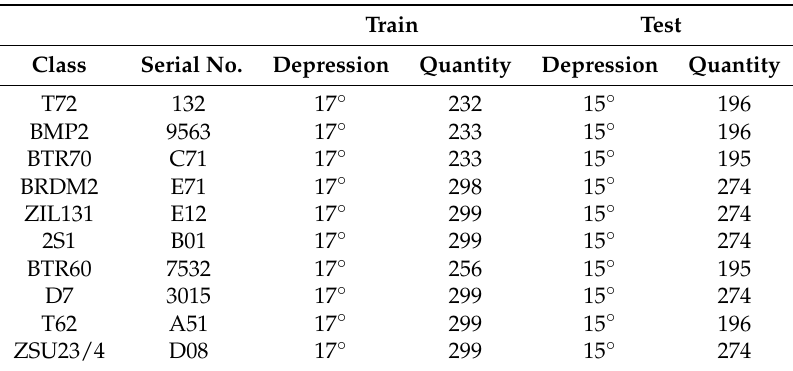
Figure 7. Experiment samples of 10 targets: optical images ( top ) and SAR images ( bottom ). Table 1. Training and Testing Images for the SOC Experimental Setup.